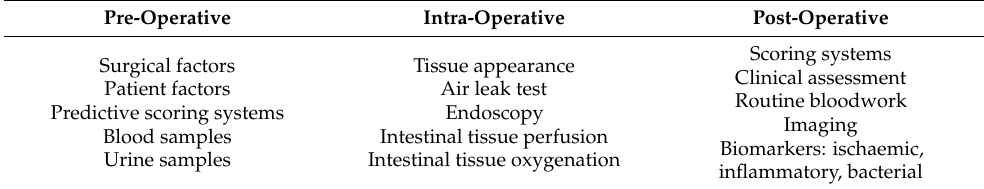
Table 2. Peri-operative techniques for AL risk prediction and